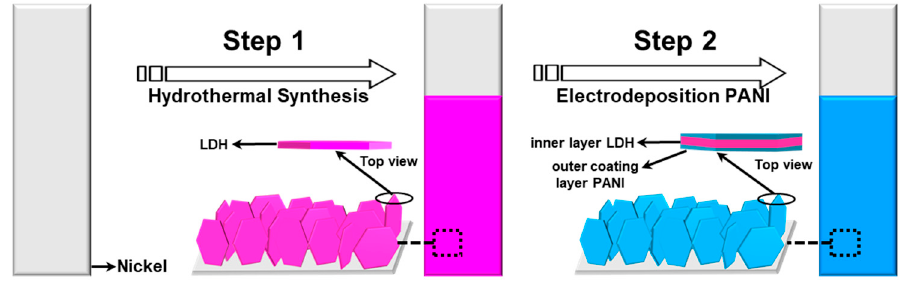
Figure 1. Schematic illustration of the two-step fabrication process of CoAl LDH-PANI nanosheet structures.